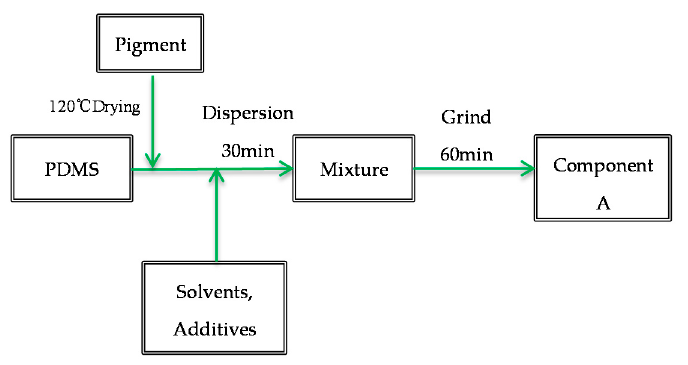
Figure 1. Preparation process of component A of silicone topcoat.